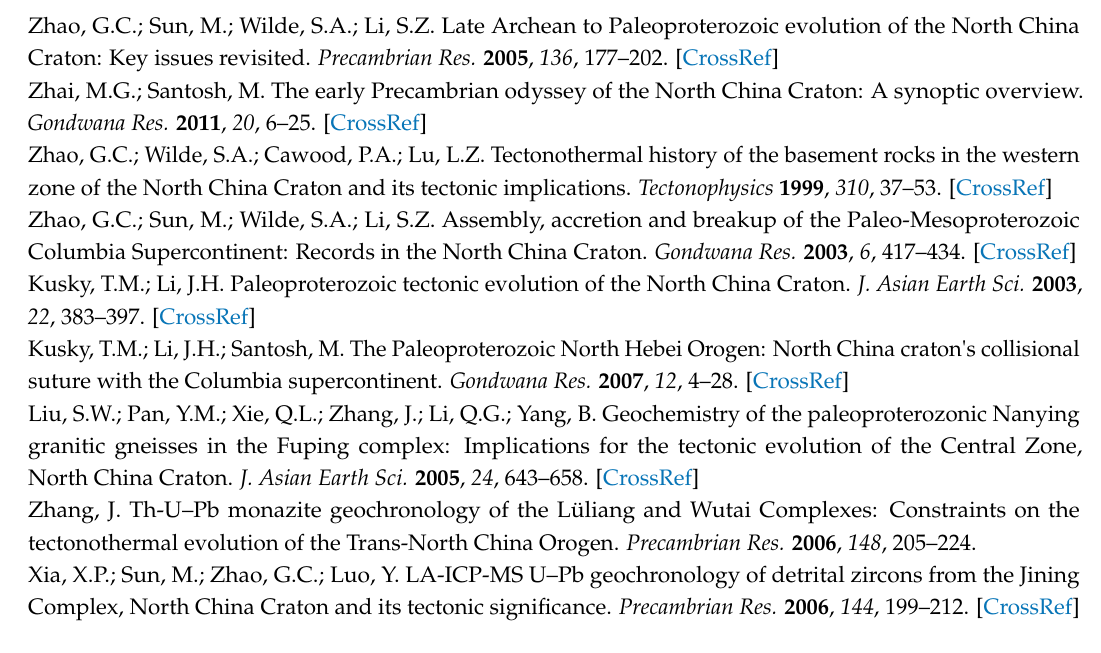
Figure S1: Nb/La-SiO 2 diagram for metagabbro, Figure S2: P 2 O 5 -SiO 2 , Y-P 2 O 5 and Th-P 2 O 5 diagram for quartz syenite, Figure S3: Mg#-SiO 2 diagram for pegmatoid leucosome, Table S1: Major element (%) and trace element (ppm) compositions for five rock types in the LS area, Table S2: Zircon La-ICP-MS U–Pb isotopic data and ages for five rock types in the LS area, Table S3: Zircon Hf isotopic data for five rock types in the LS